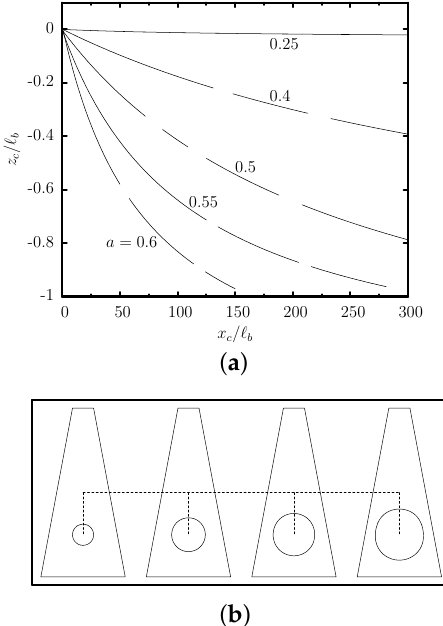
Figure 9. ( a ) Evolution of the centroid z c versus the centroid x c , for a capsule with a / (cid:96) b = 0.25,0.4,0.5,0.55,0.6 and Ca = 0.1, flowing in a trapezoidal channel with (cid:96) z / (cid:96) b = 2 and (cid:96) a / (cid:96) b = 0.25. The curves were derived from our computations for different initial positions z 0 c / (cid:96) b in the range [ ( b ) The steady-state side profile for a / (cid:96) b =